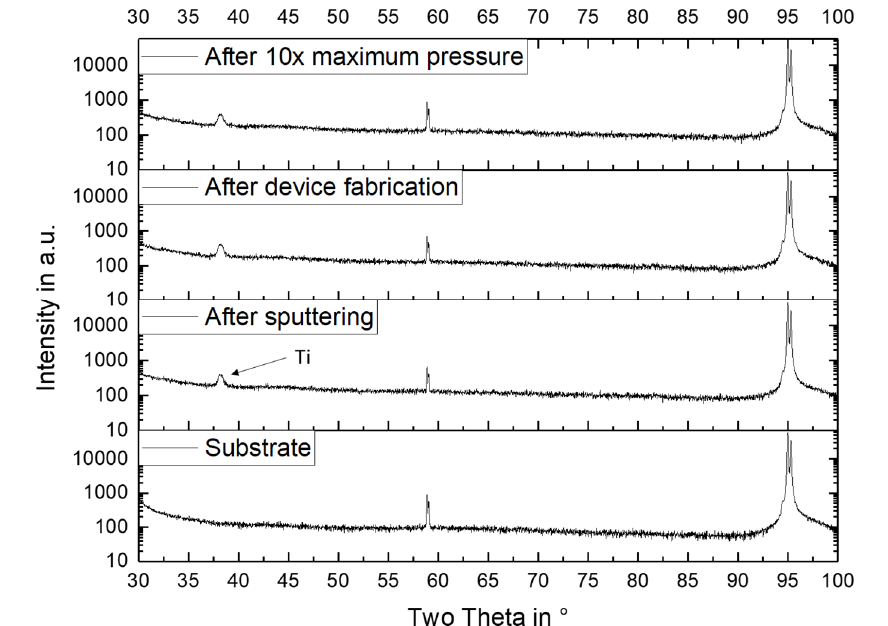
Figure 12. X-ray di ff raction (XRD) pattern of the diaphragm metallization at di ff erent stages of Figure 12. X-ray diffraction (XRD) pattern of the diaphragm metallization at different stages of fabrication and measurement, in comparison with the di ff raction pattern of the Si fabrication and measurement, in comparison with the diffraction pattern of the Si substrate.